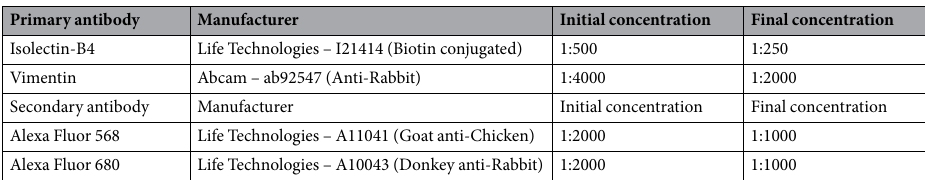
Table 1. Primary and secondary